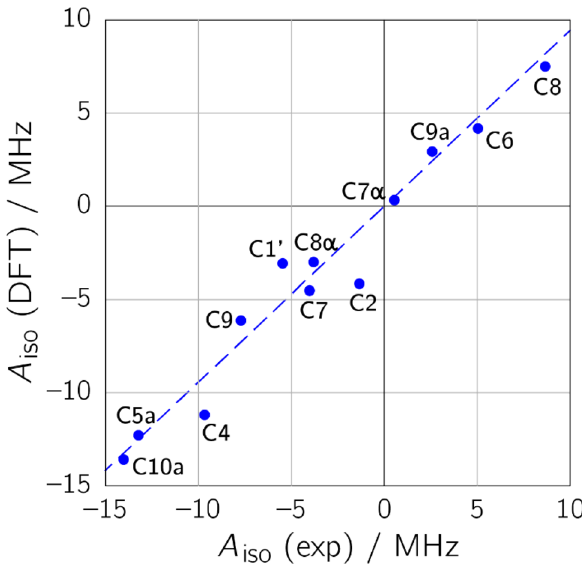
Figure 3. ENDOR/DFT correlation plot for the isotropic 13 C hyperfine coupling constants of the neutral FAD radical in E. coli photolyase. The dashed blue line represents a linear regression fit constrained to go through the origin ( R 2 = 0.9576; slope 0.9440).